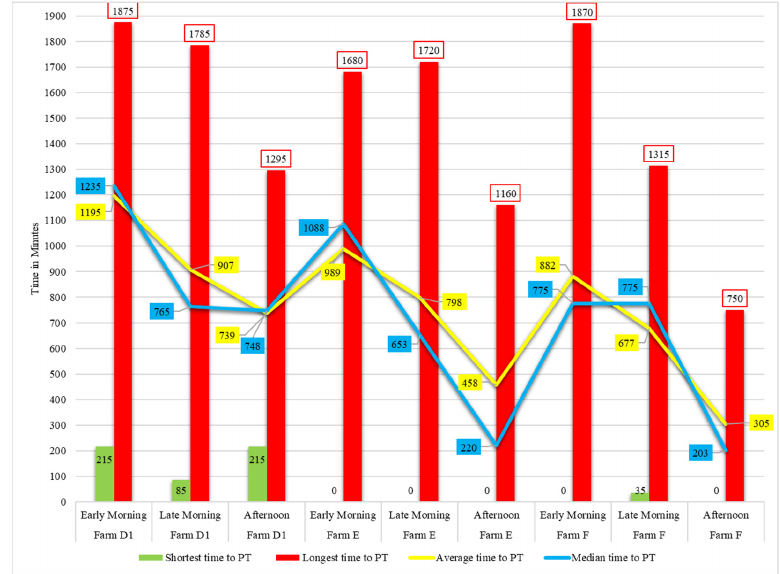
Figure 11. Time in minutes to reach PT = 0 °C on Gauteng farms. Source: [13].